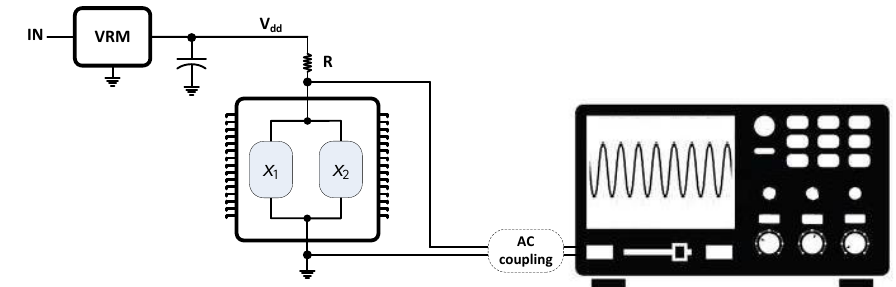
Figure 1: A typical SCA measurement